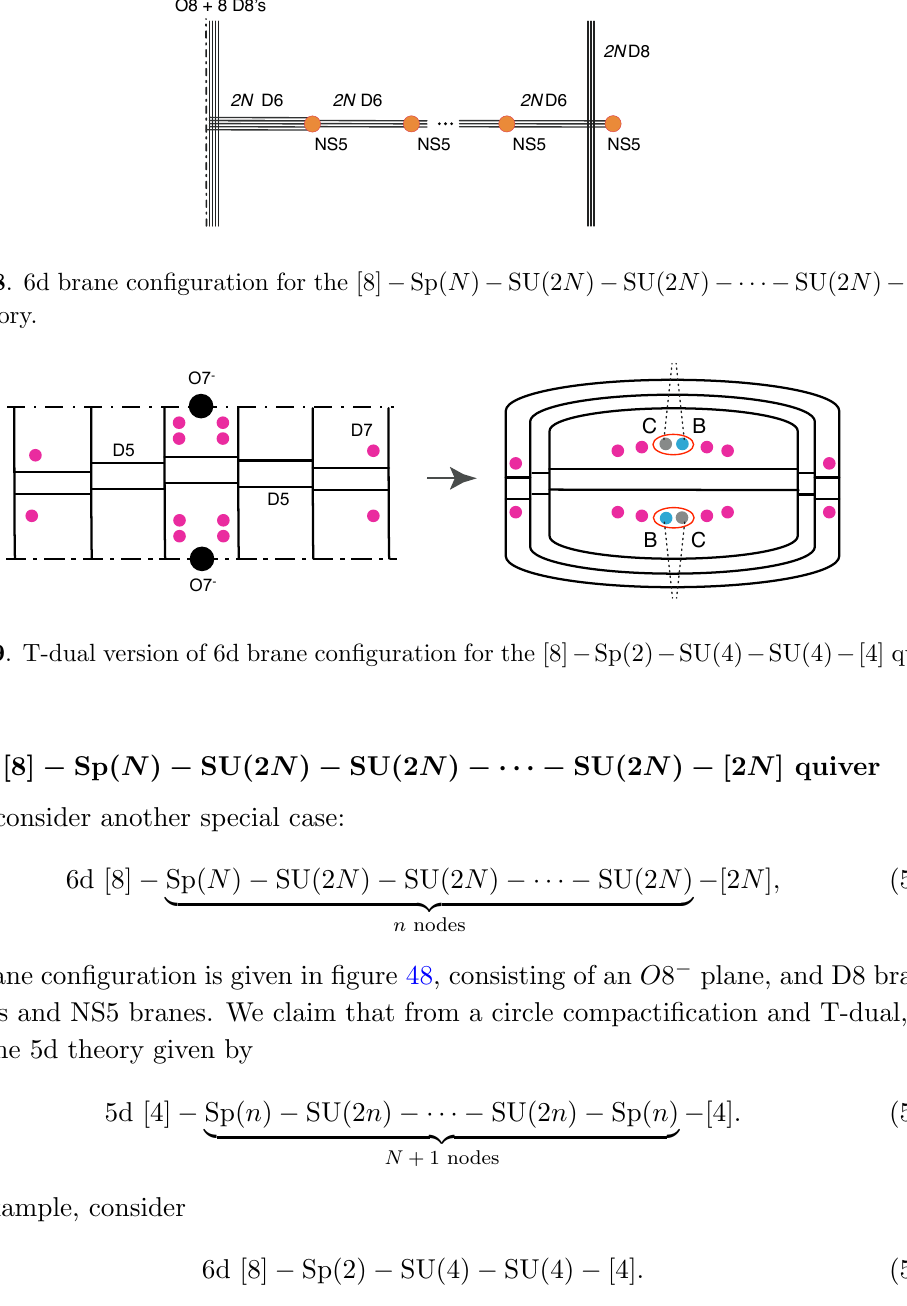
Sp( N ) SU(2 N ) SU(2 N ) SU(2 N ) [2 N ] (cid:0) (cid:0) (cid:0) (cid:0) (cid:1) (cid:1) (cid:1) (cid:0) (cid:0)